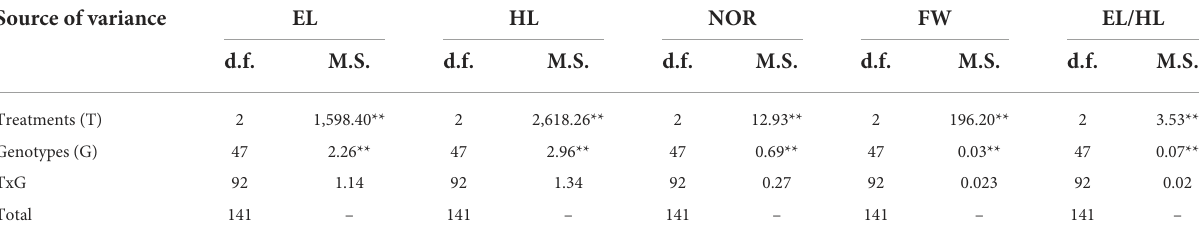
TABLE 2 Mean square (M.S.) of Epicotyl length (EL), Hypocotyl length (HL), number of roots (NOR), fresh weight (FW), and shoot length/root length ratio under three salt treatments with different concentrations (10, 40, and 50%) in a set of 48 wheat genotypes. Source of